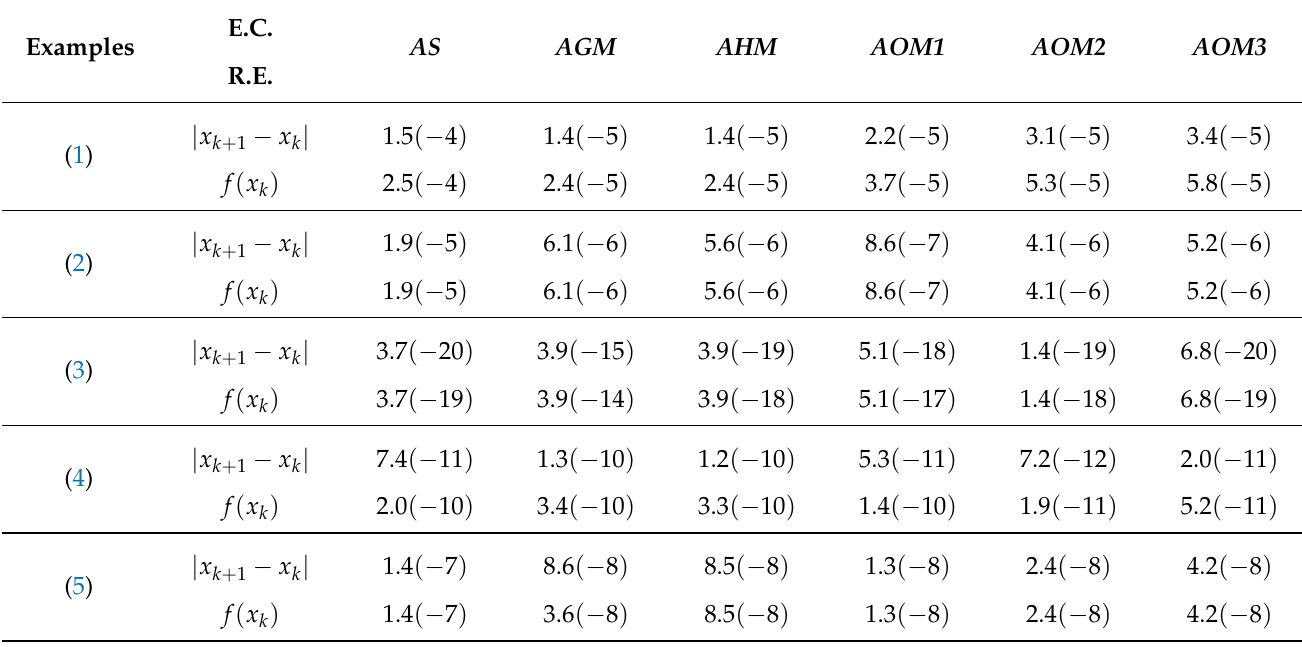
Table 4. Comparison of our methods with standard Agarwal scheme after k = 12 number of